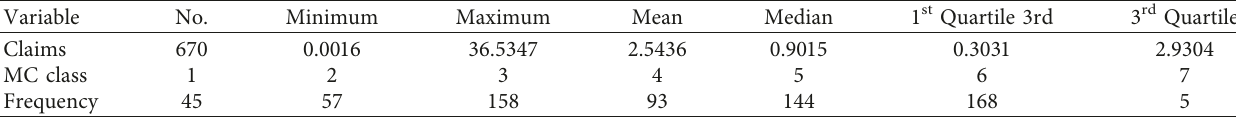
Table 11: Descriptive statistics of data.